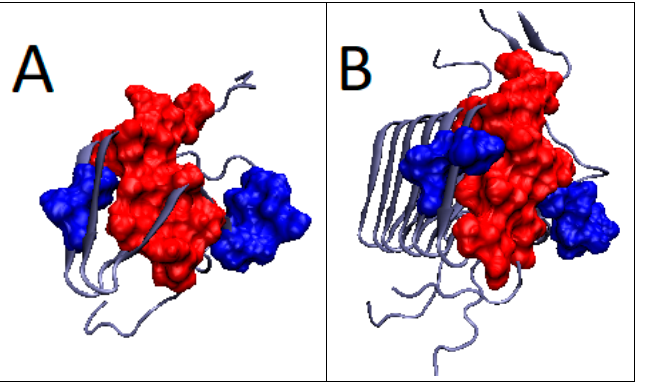
Figure 16. 3D presentation of 2KJ3 amyloid structure showing micelle-like status. ( A ) 2KJ3—indi- vidual chain—red residues indicates components of the hydrophobic core determined on the basis of the profiles (from Figure 15A). ( B ) 2KJ3—chain as part of fibril—red residues indicate compo- nents of the hydrophobic core determined on the basis of the profiles (from Figure 15B). The resi- dues distinguished as navy blue—the residues with a status inconsistent with the T distribution, determined on the basis of profiles in Figure 15.